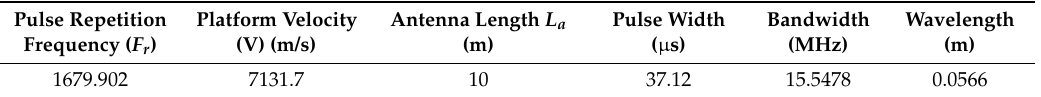
Table 5. The related SAR parameters of the ERS-2.